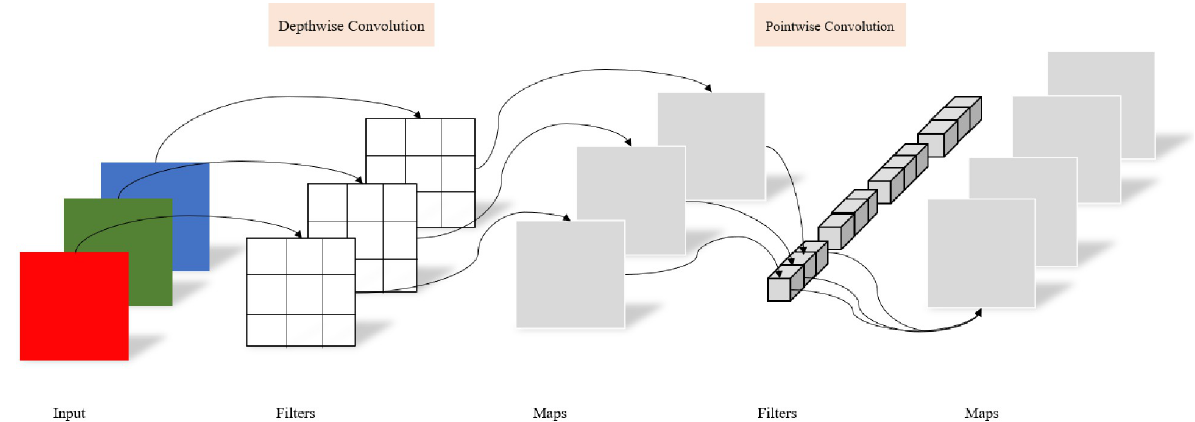
Fig 4. Schematic diagram of depth separable